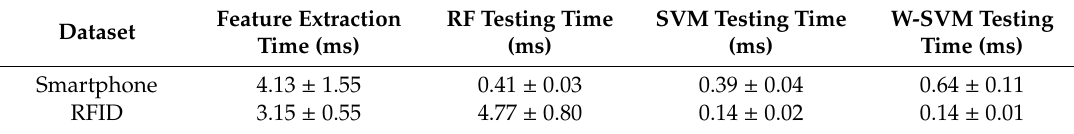
Table 6. Overall performance and performance by class using different classifiers on RFID dataset.